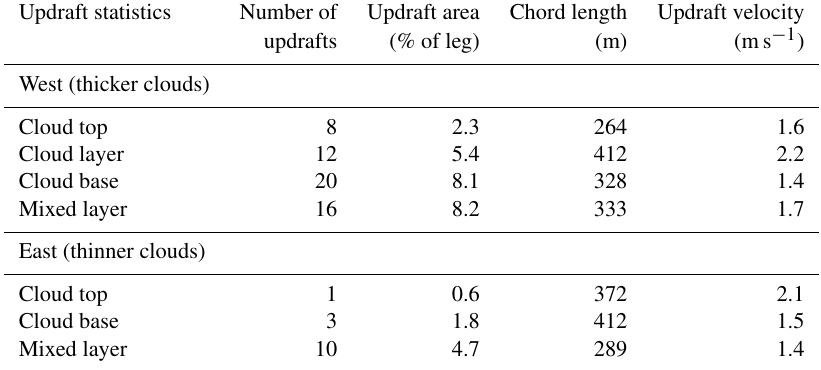
Table 1. Number of updrafts, relative updraft area, average updraft size, and average updraft speed for the legs flown on 4 June 2019. Updraft